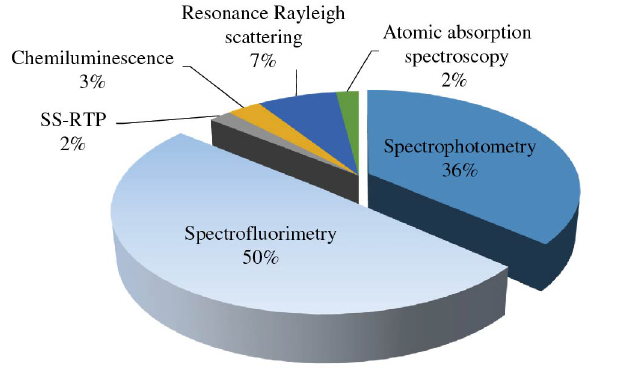
Figure 5: Summary for the reported spectroscopic method utilizing eosin Y as a reagent. SS-RTP is solid substrate-room temperature